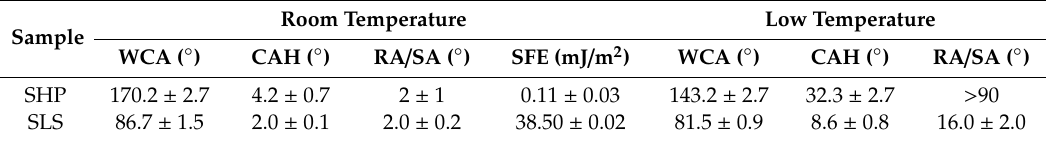
Table 2. Wettability and surface free energy at room and low temperatures.